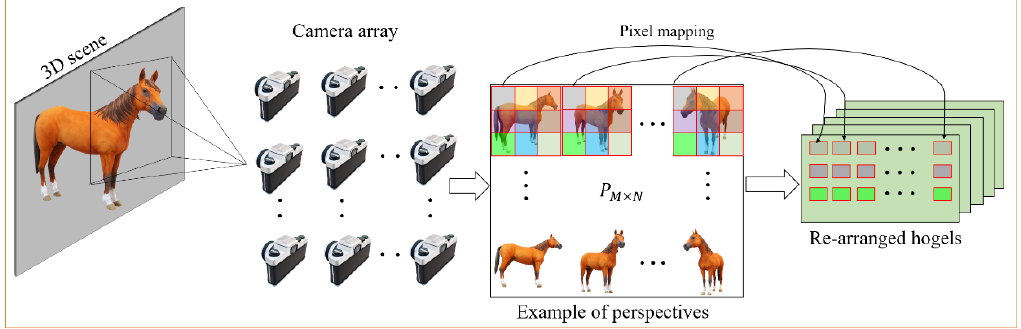
Figure 1. Schematic configuration of hogel-based holographic stereogram synthetization.